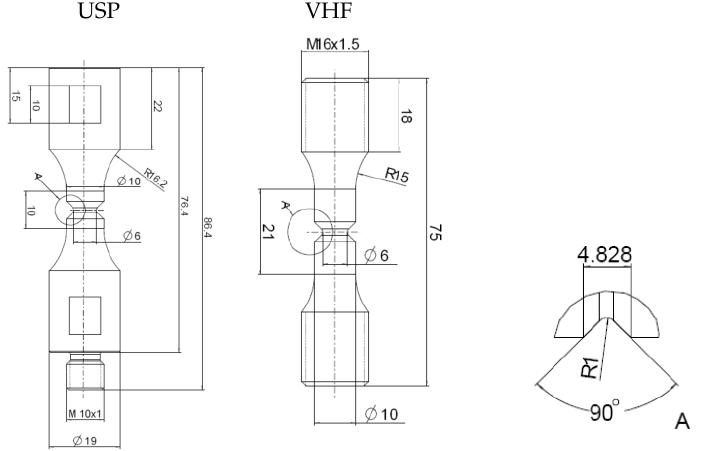
Figure 4. Geometry of specimens with ultimate tensile strength 919 as well as 1726 MPa and K = 2.06